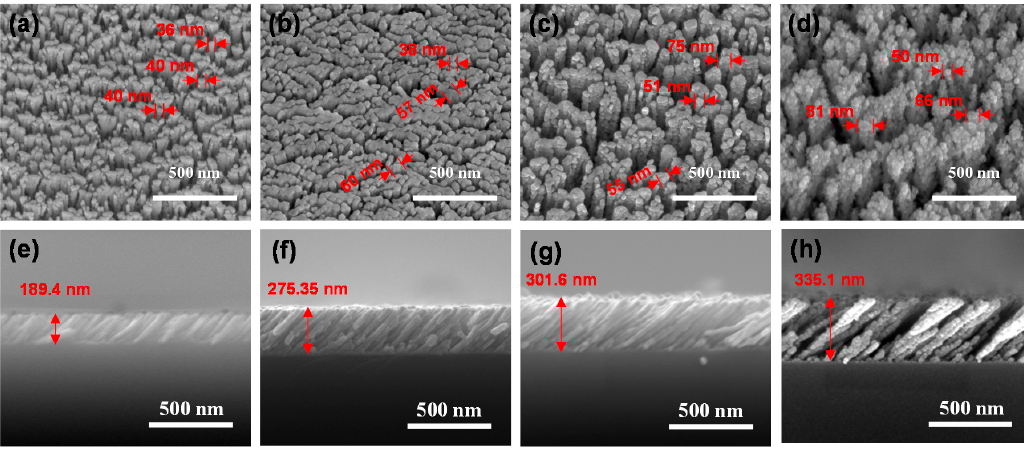
Figure 2. Plain-view SEM images of the ( a ) NiO; ( b ) WO 3 ; ( c ) SnO 2 and ( d ) In 2 O 3 NCs; ( e – h ) show cross-sectional SEM images of ( a – d ), respectively.